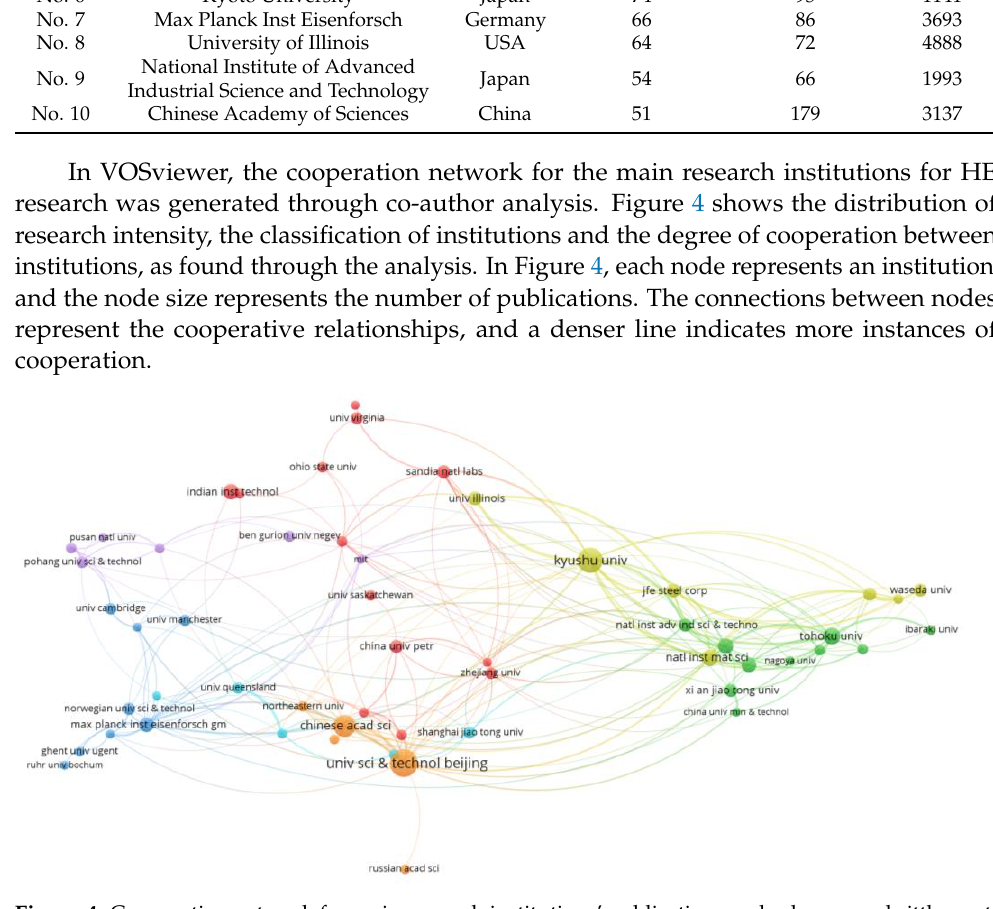
Figure 4. Cooperation network for main research institutions ’ publications on hydrogen embrittle-